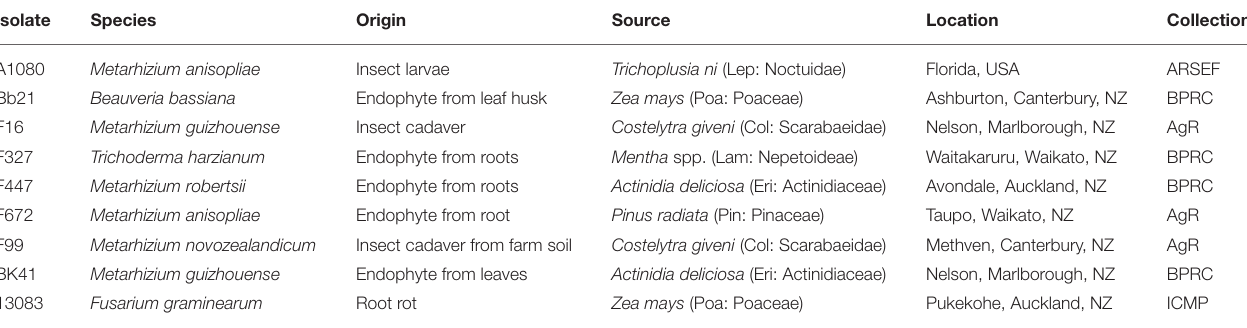
TABLE 1 | Voucher information for the specimens used in this